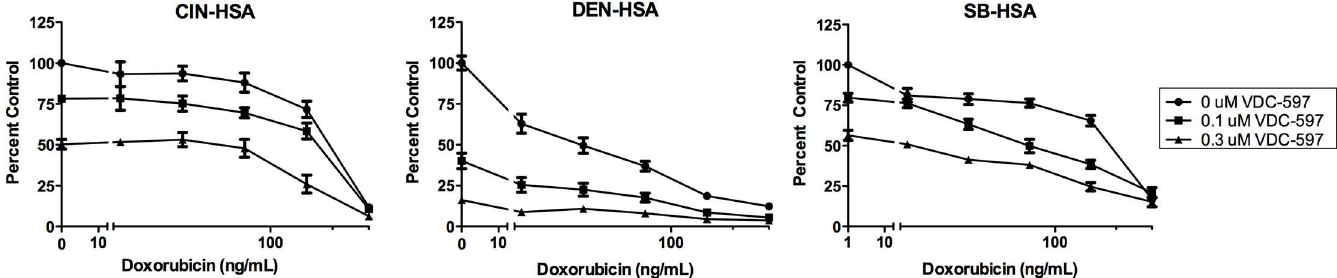
Fig 4. VDC-597 in combination with doxorubicin provides additive inhibitory effects on canine hemangiosarcoma cell growth. DEN, CIN, and SB-HSA cells were incubated in C/10 EMEM with varying concentrations of doxorubicin, or co-treated in C/10 EMEM with VDC-597 and doxorubicin for 72 hours followed by determination of relative viable cell number as above. Error bars indicate standard error